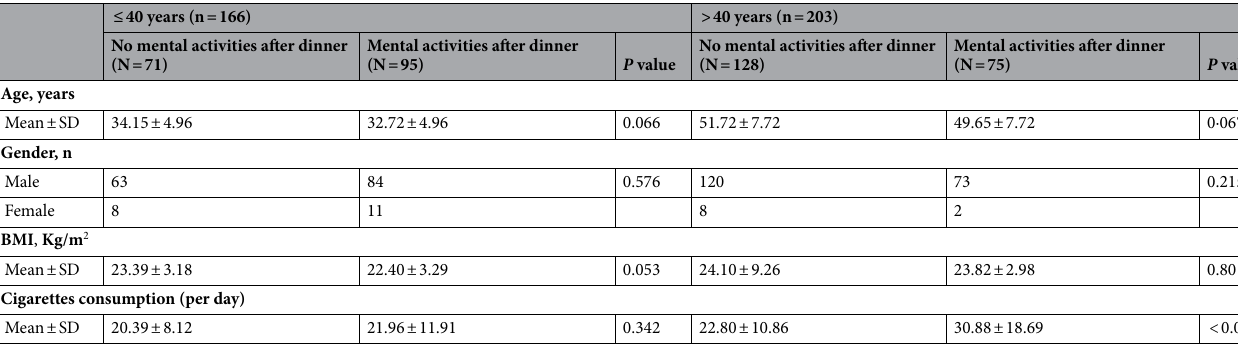
Table 1. Survey results in two groups.